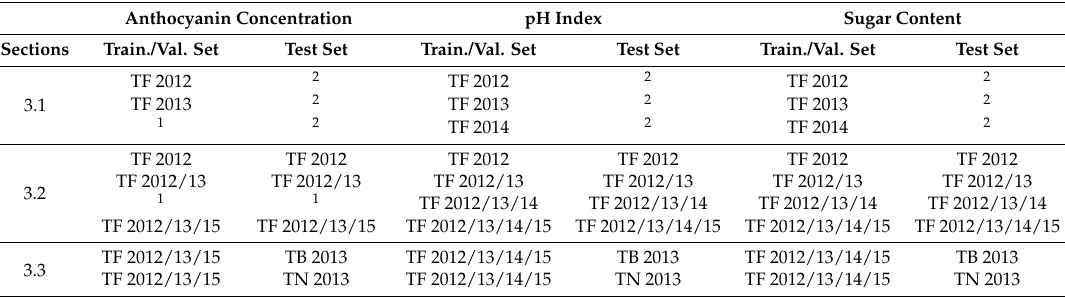
Table 4. Outline of the different experiments performed in the sections